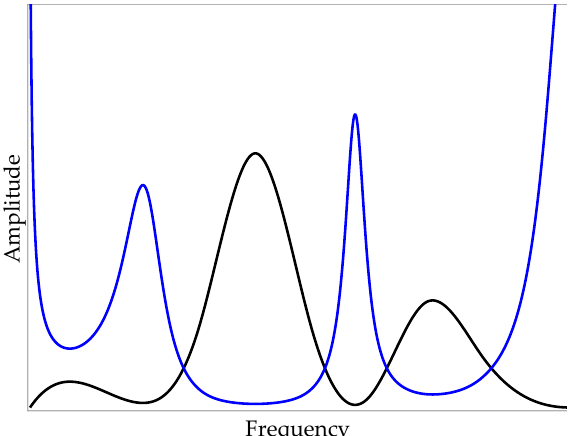
Figure 3. Hypothetical spectrum of the o ff -bridge signal (black) and corresponding filter shape prototype